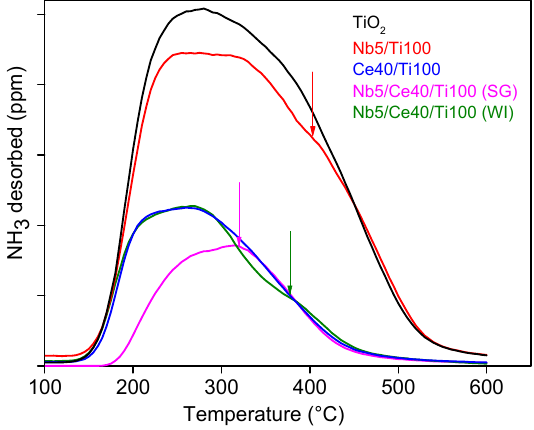
Figure 6. NH 3 -TPD plots of supported Ceria-based catalysts and reference materials.